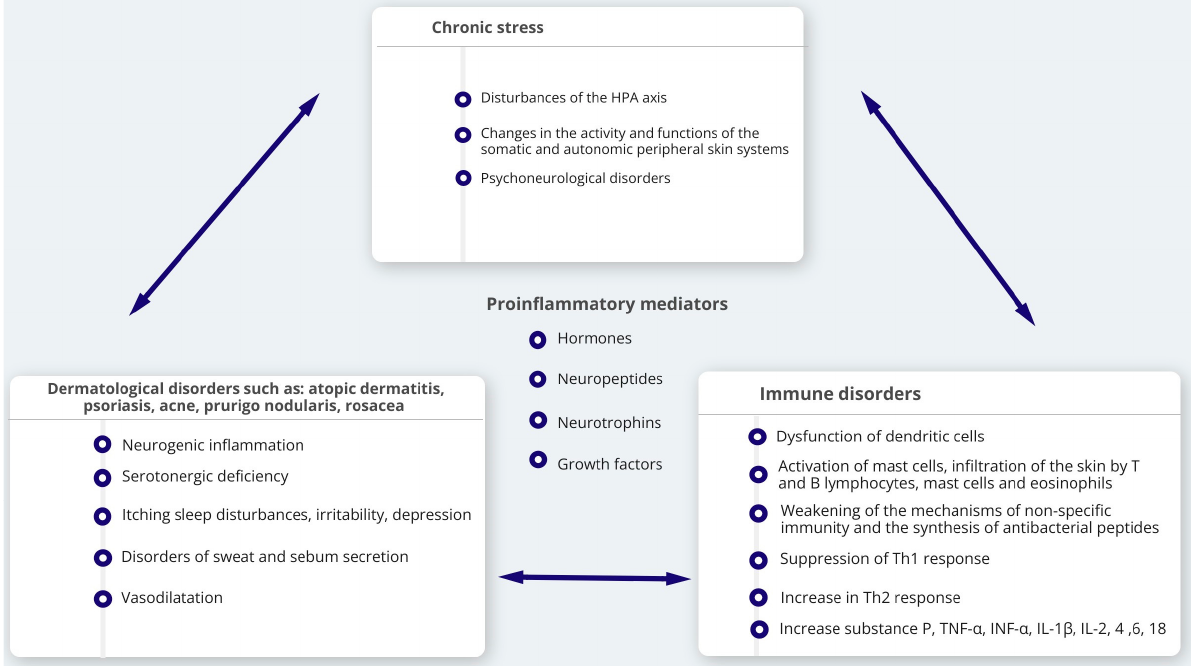
Figure 2. The role of stress and mediators produced by cells of the nervous system, immune system and resident cells of the skin in the induction and exacerbation of symptoms of chronic dermatitis and the formation of disorders of specific and non-specific immunity of the skin. In response to stress, the hypothalamus, through the corticotropin-releasing hormone (CRH), stimulates the release of ACTH, activating the production of cortisol by the adrenal cortex [120,126]. The body’s primary line of defense in the face of environmental factors is the skin, and the second is molecular mechanisms, through which the body responds to threats and restores local homeostasis. The fundamental bodily system involved in the response to stress is the hypothalamic–pituitary–adrenal (HPA) axis. The presence of an analog of the HPA axis has been demonstrated in the skin, which is activated by various environmental factors [2,127,128]. Several hormonal changes occur due to stress factors in the HPA axis, which initiates CRF secretion in the hypothalamus; this hormone binds to a type 1 receptor in the anterior pituitary gland and stimulates the secretion of ACTH by the anterior pituitary gland through corticotropin-releasing hormone (CRH) production and secretion of the adrenocorticotropic hormone (ACTH) from POMC. ACTH travels through the bloodstream to the cells of the adrenal cortex and affects the production negative feedback, affects hormones secreted by the hypothalamus (CRF) and pituitary gland (POMC) (Figure 3) [129].